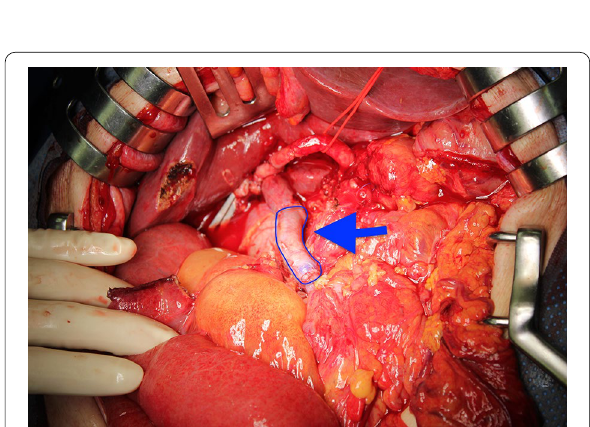
Fig. 4 Abdominal ultrasonography. There was an echogenic region in the lumen of the blood vessel at a section less than 6 cm from the upper end of the superior mesenteric vein, which was considered a tumor thrombus (arrow)